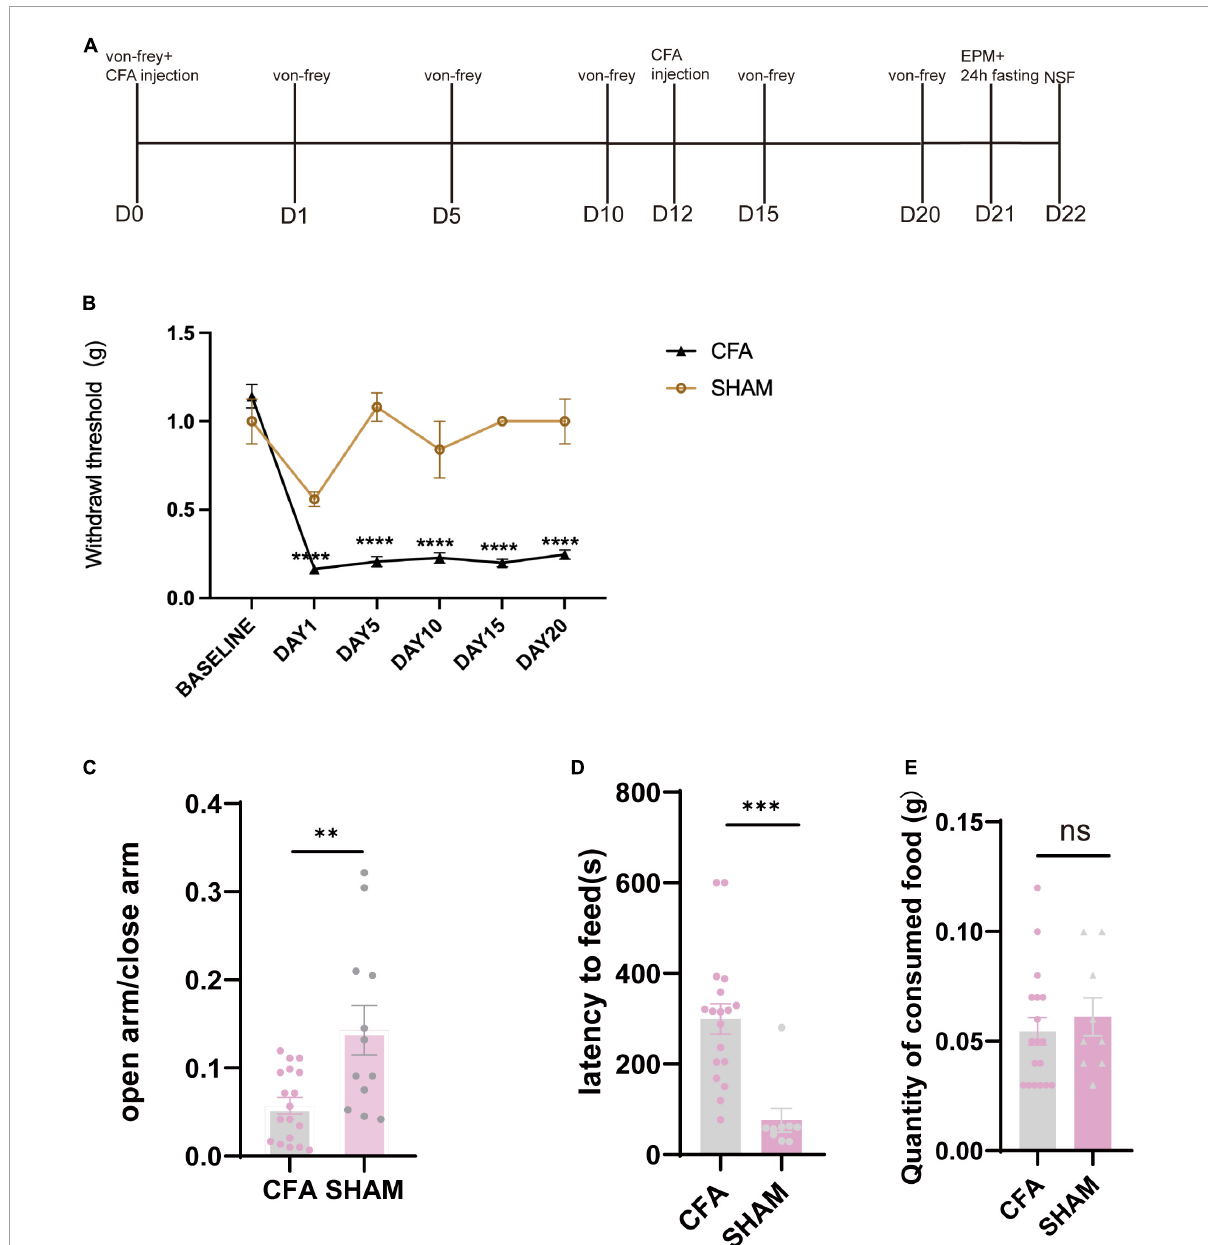
FIGURE2 Mice showed anxiety-like behavior after the chronic inflammatory pain model. (A) Timeline of CFA injection and subsequent behavioral tests. (B) Withdrawal threshold of CFA and SHAM groups during the modeling process (CFA: n = 24, SHAM: n = 12 baseline p = 0.4690 days 1–20: p < 0.0001, Mann–Whitney test). (C) The ratio of time in the open arm and time in the closed arm of CFA and SHAM groups 21 days after the first CFA injection (CFA: n = 18, SHAM: n = 12, p = 0.0023, unpaired t -test). (D) Latency to feed of CFA and SHAM groups (CFA: n = 18, SHAM: n = 9, p = 0.0002, unpaired t -test). (E) Quantity of food consumed in home cage feeding test (CFA: n = 18, SHAM n = 9, p = 0.5408, unpaired t -test).